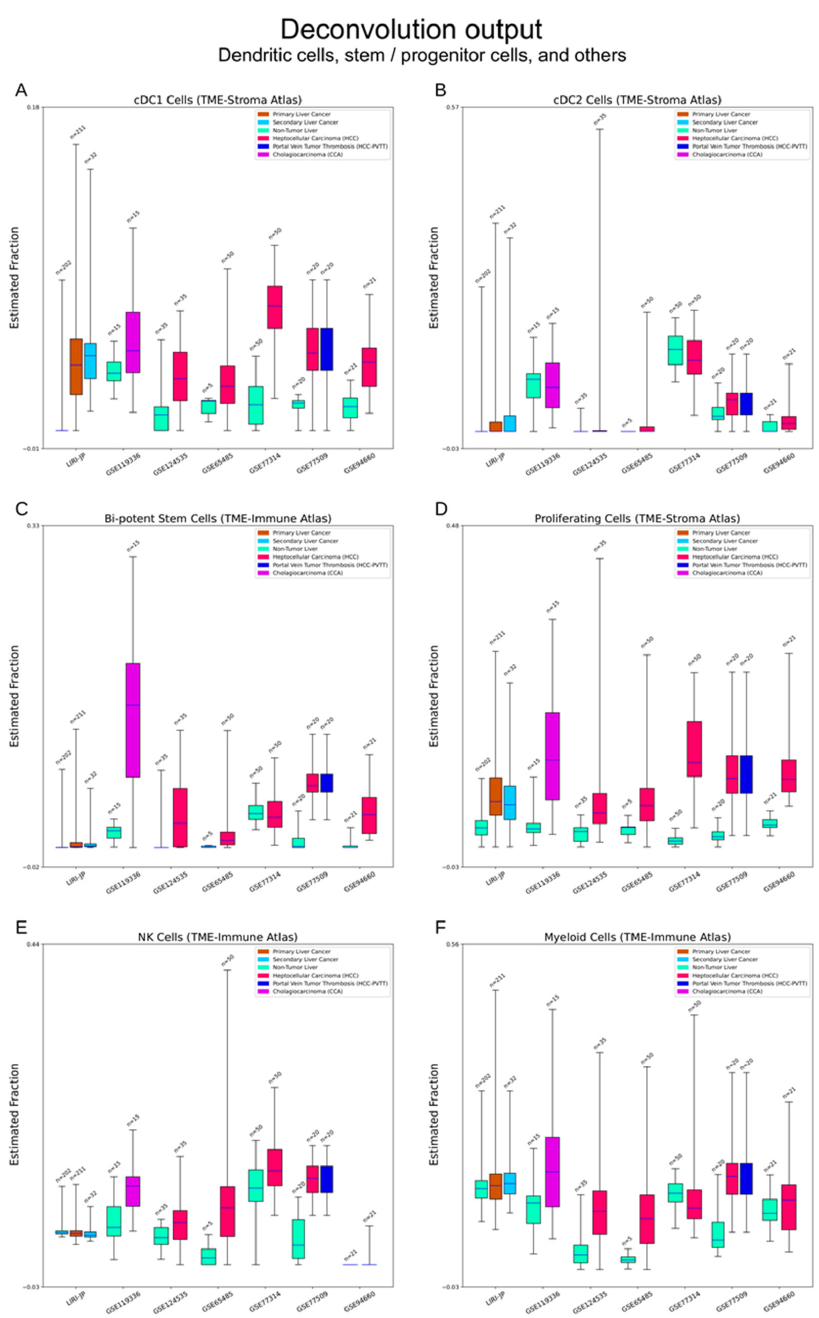
Figure 6. Deconvolution output—dendritic cells, stem/progenitor cells, and others. ( A , B ) Estimation of conventional dendritic cells (cDCs). Elevations of cDC1s can be seen in liver cancers. ( C , D ) Esti- mation of two types of proliferative cells. Bi-potent stem cells are a group of late-stage pluripotent cells with potential to differentiate into hepatocytes and cholangiocytes. The TME-Stroma atlas did not clarify the exact characteristics of proliferating cells. Its signature genes suggest its pluripotent origin. Elevations of these two cell types can be seen in liver cancers. ( E , F ) Estimation of natural killer (NK) cells and myeloid cells. NK cells belong to innate immune branch and myeloid cells are the hematopoiesis-originated immune branch. Deconvolution of these two cell types shows altered activities in liver cancers, but no direct association can be